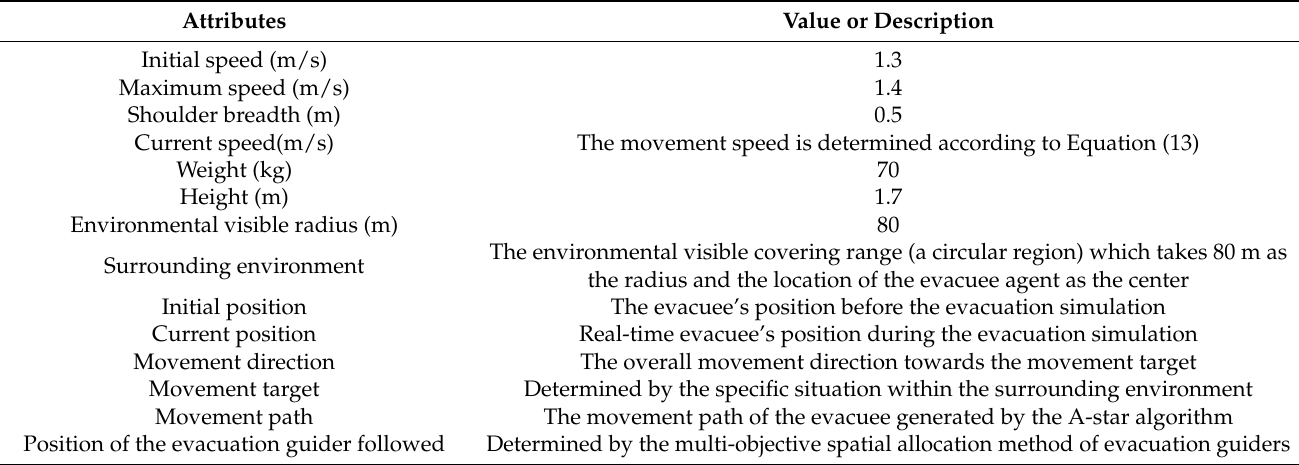
Table 2. Attributes of the evacuee